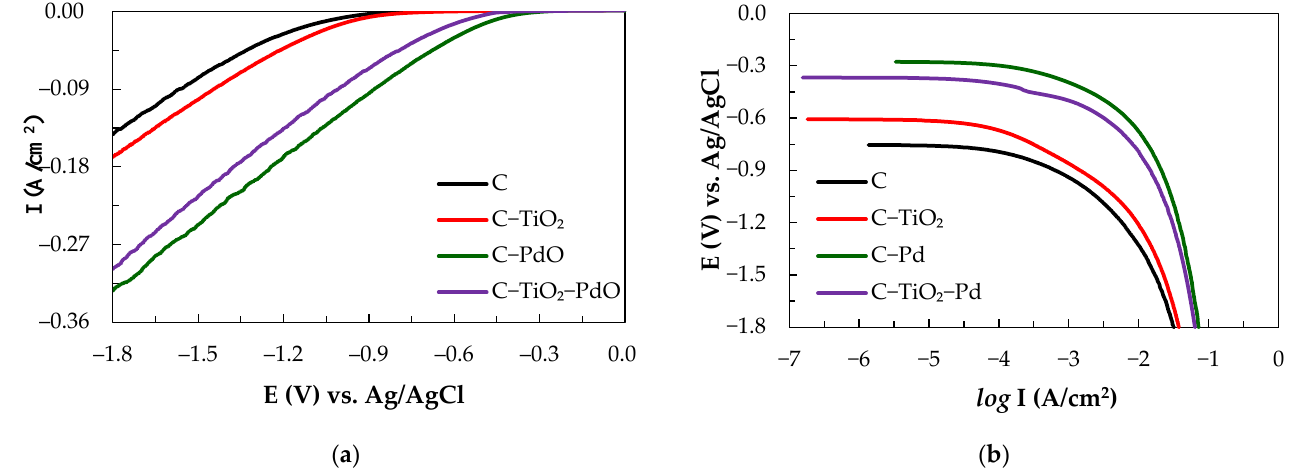
Figure 1. CV tests for ( a ) cathodic polarization curves and ( b ) linear polarization curves recorded on various electrodes in 0.1 M CH 3 SO 3 H solution at a scan rate of 1 mV/sec. Table 1. The HER kinetic parameter analysis of the linear polarization curves for various electrodes in 0.1 M CH 3 SO 3 H solution.